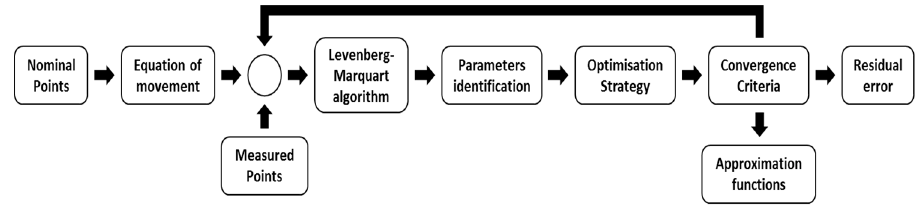
Figure 5. Characterization Procedure Scheme.